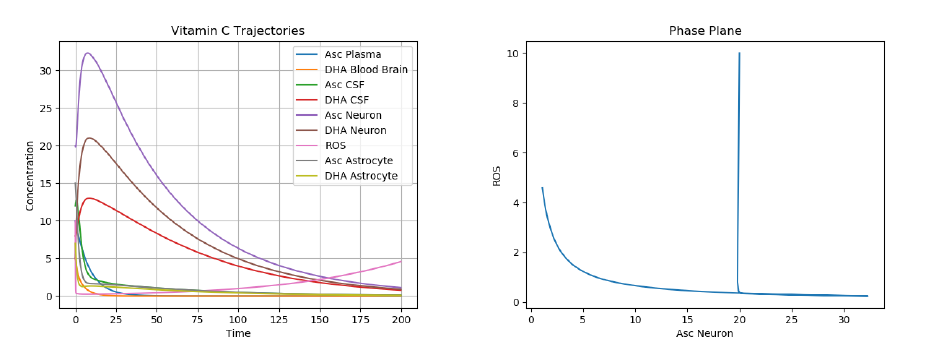
Figure 7. Dynamics of AA, DHA, and ROS in AD